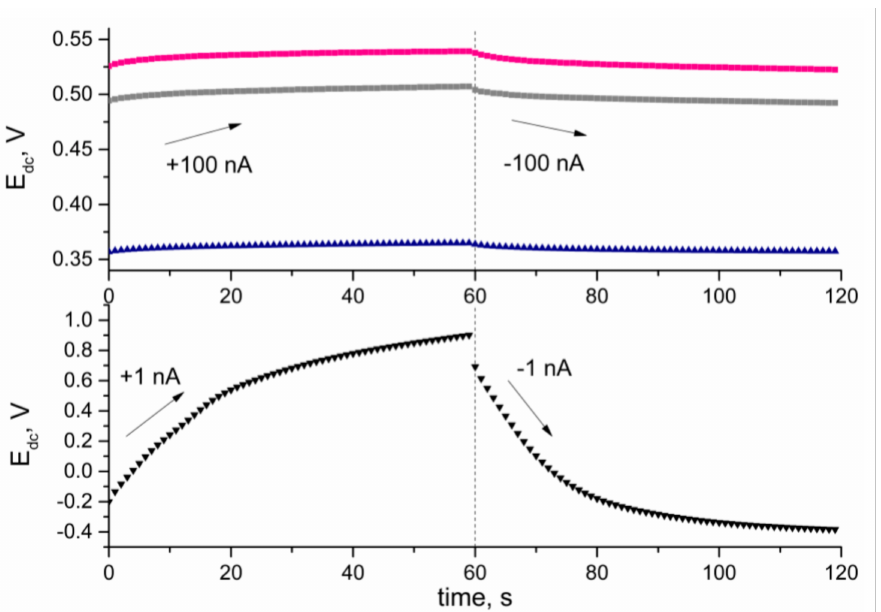
Figure 6. Chronopotentiograms of GC/CB+RuO 2 /K + -ISM ( (cid:4) ), GC/NT+RuO 2 /K + -ISM ( • ), GC/GR+RuO 2 /K + -ISM ( (cid:78) ), and GC/K + -ISM ( (cid:72) )